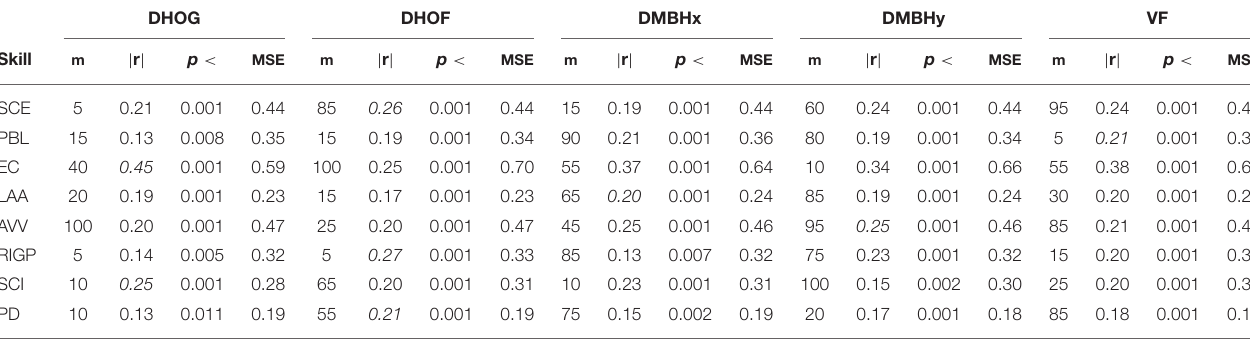
The optimal number of clusters (m), regression coefficients with respective p-values and MSE scores are shown for each skill. The highest correlations are highlighted for each method and skill. Bonferroni correction is applied which resulting in a significance level of p < 0.003 . The best visual feature results are in